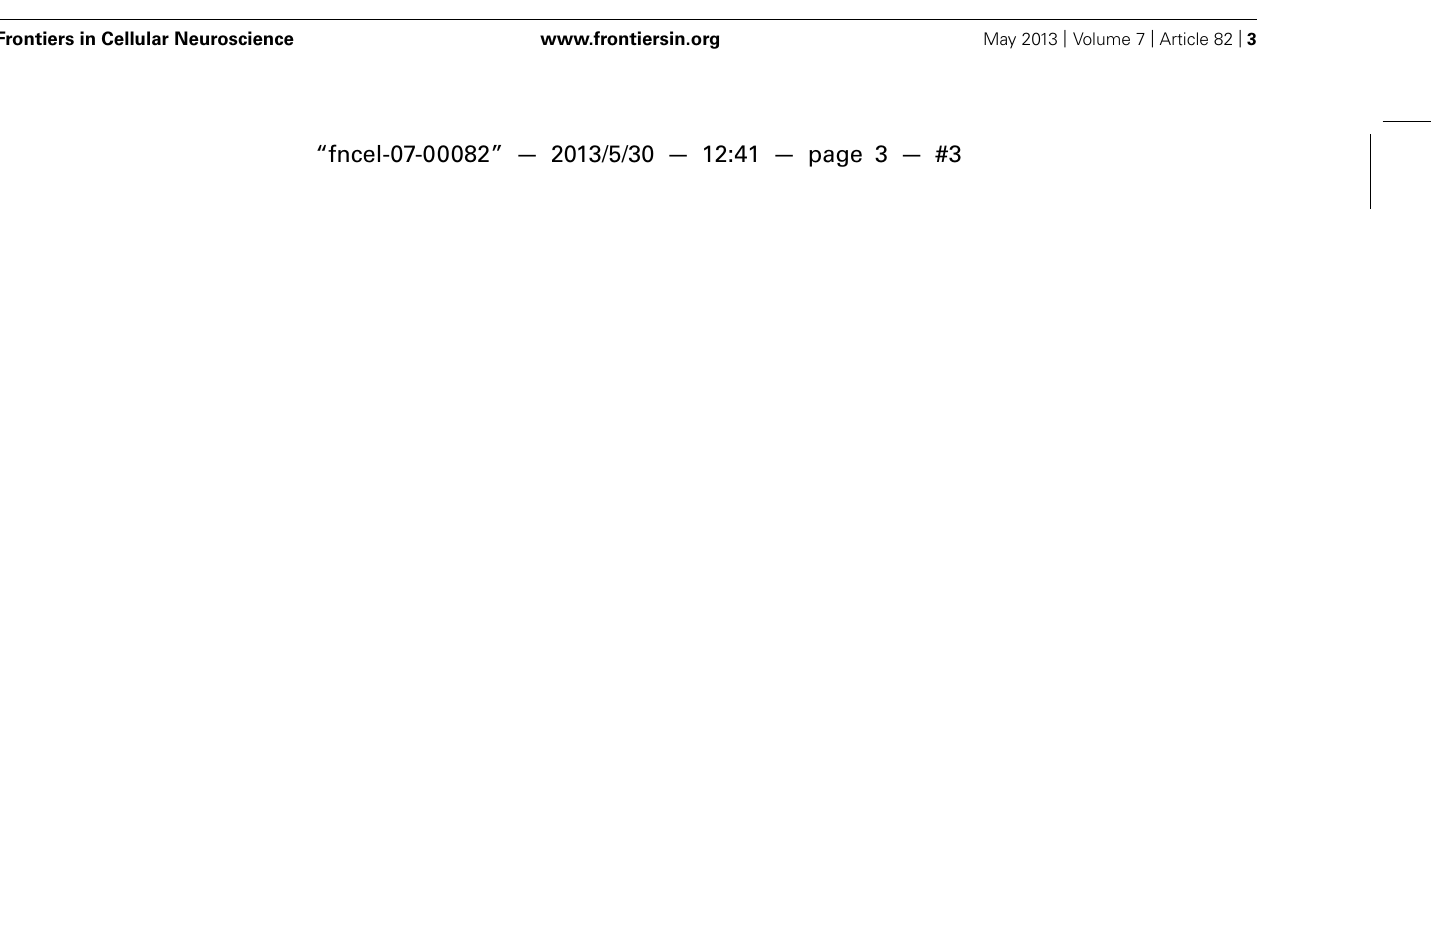
regulation of signaling pathways. In addition, LRRK2 has been implicated in proliferation and may therefore also govern early stages of neurogenesis.The interaction between microtubule function, vesicle trafficking, autophagy and proliferation and the canonicalWnt pathway is depicted but other pathways are likely to play additional